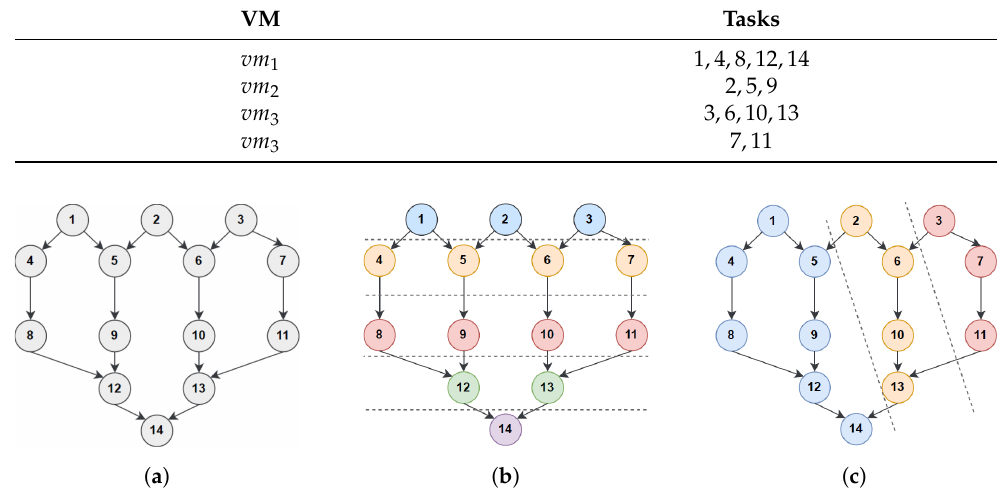
Figure 3. Scheduling example. ( a ) Input DAG; ( b ) Level-based approach; ( c ) Hierarchy-based approach.